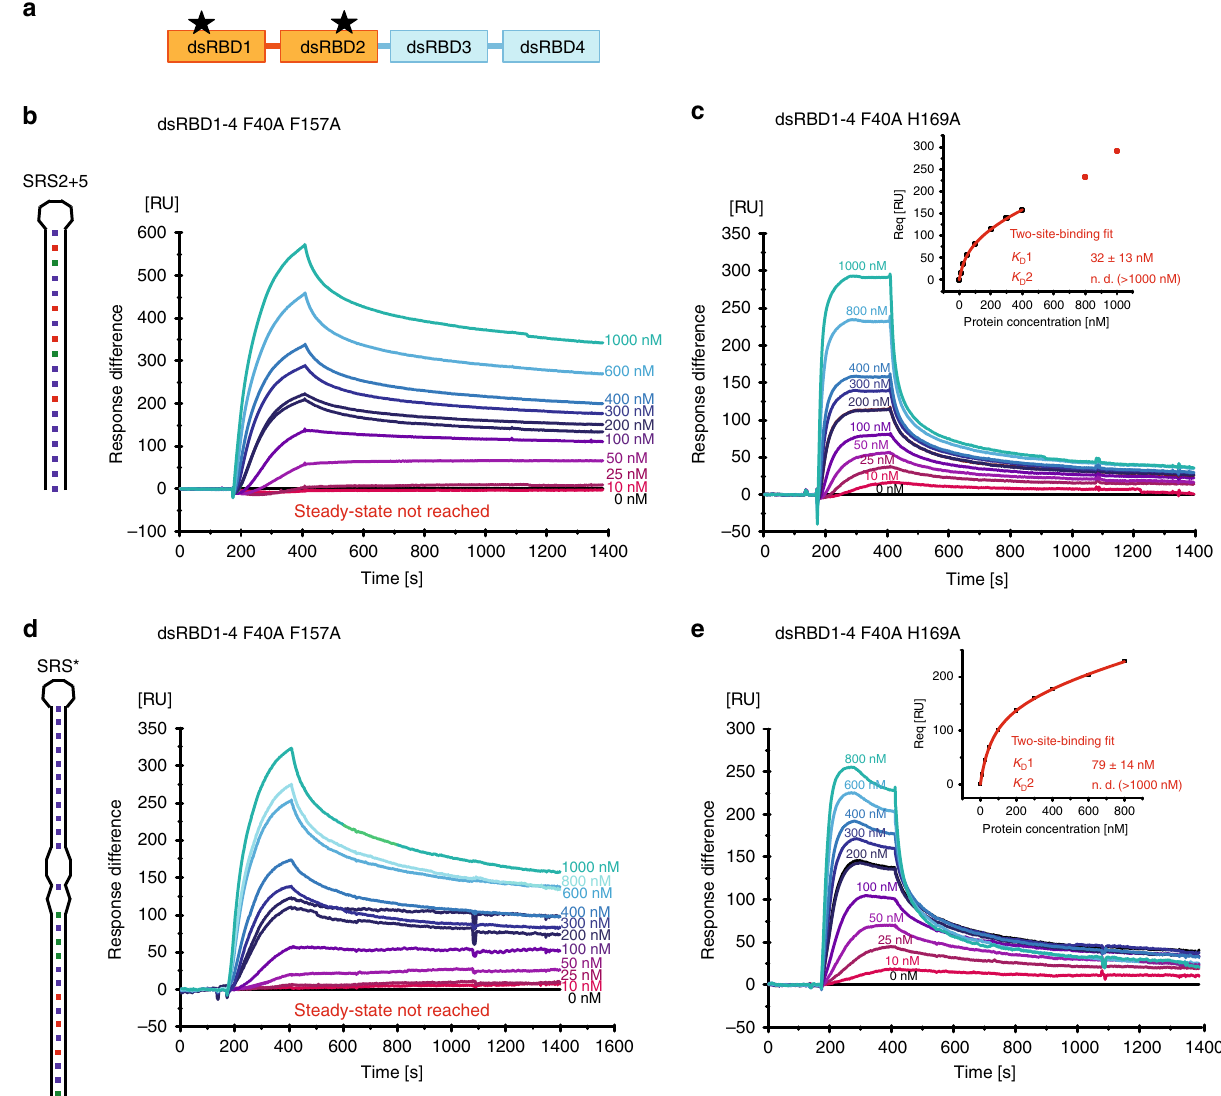
Fig. 5 SPR with mutated dsRBD 1 – 4 con fi rms a contribution of dsRBD1 – 2. a Schematic drawing of mStau2 with its two mutations in dsRBD 1 – 2. b , c SPR experiments with mStau2 dsRBD 1 – 4 double-mutants binding to SRS2 + 5 RNA and d , e to SRS*. Binding to ( b ) SRS2 + 5 and ( d ) SRS* is strongly decreased for the F40A F157A mutant as compared to mStau2 dsRBD 1 – 4 wild-type. Binding of the F40A H169A mutant shows dramatically altered kinetics ( c , e ) as compared with dsRBD 1 – 4 wild-type and resembles binding by the tandem domain dsRBD 3 – 4 alone. ± indicates standard deviation. Source data are provided as a Source Data fi